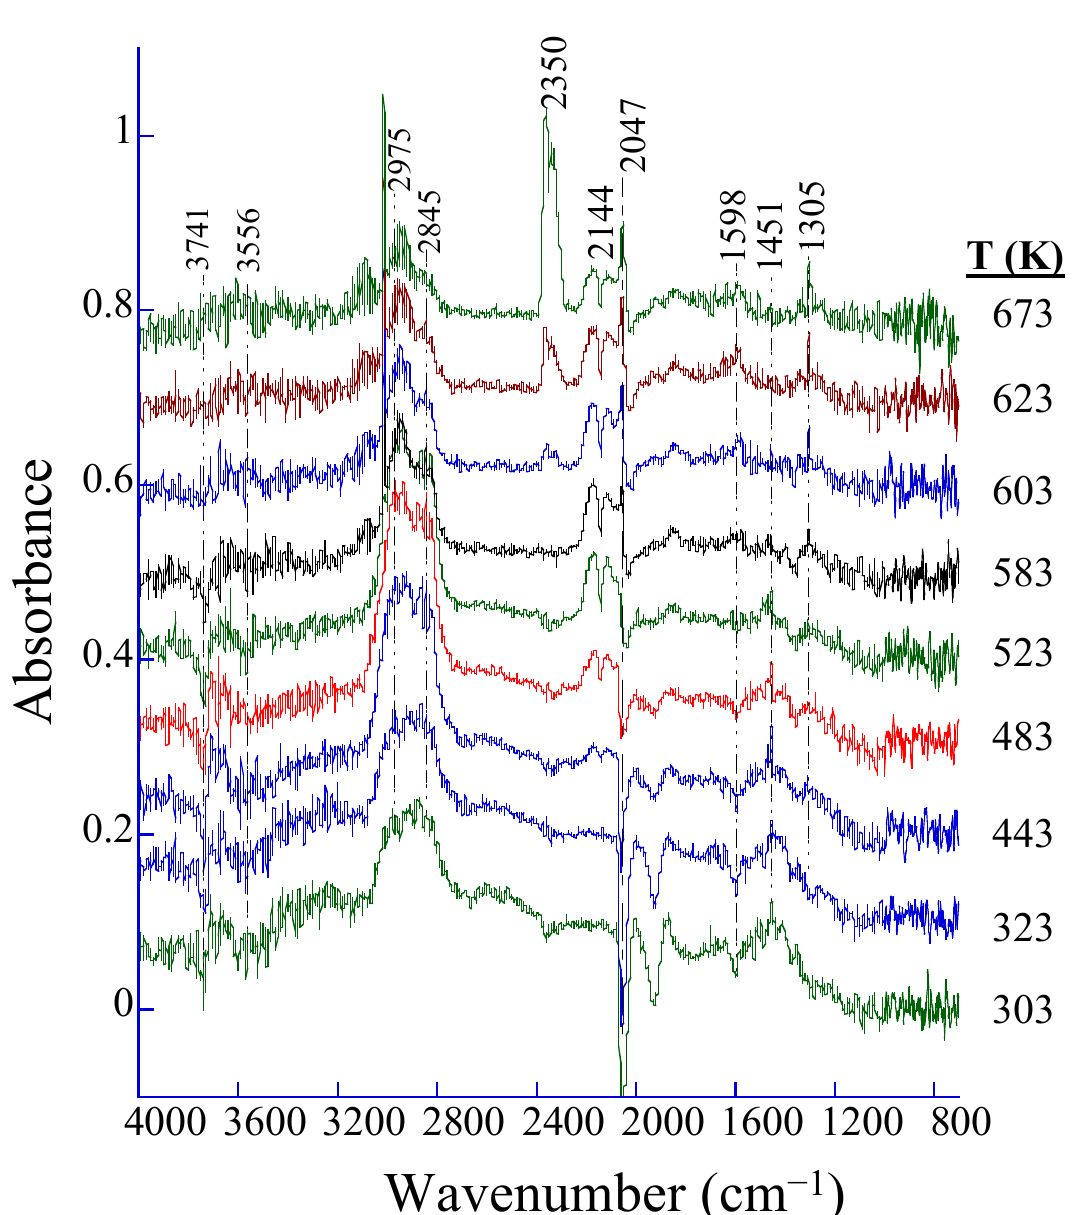
Figure 6- IR spectra during the exposure of the Rh/Al 2 O 3 catalyst to methanol flow at different temperatures.